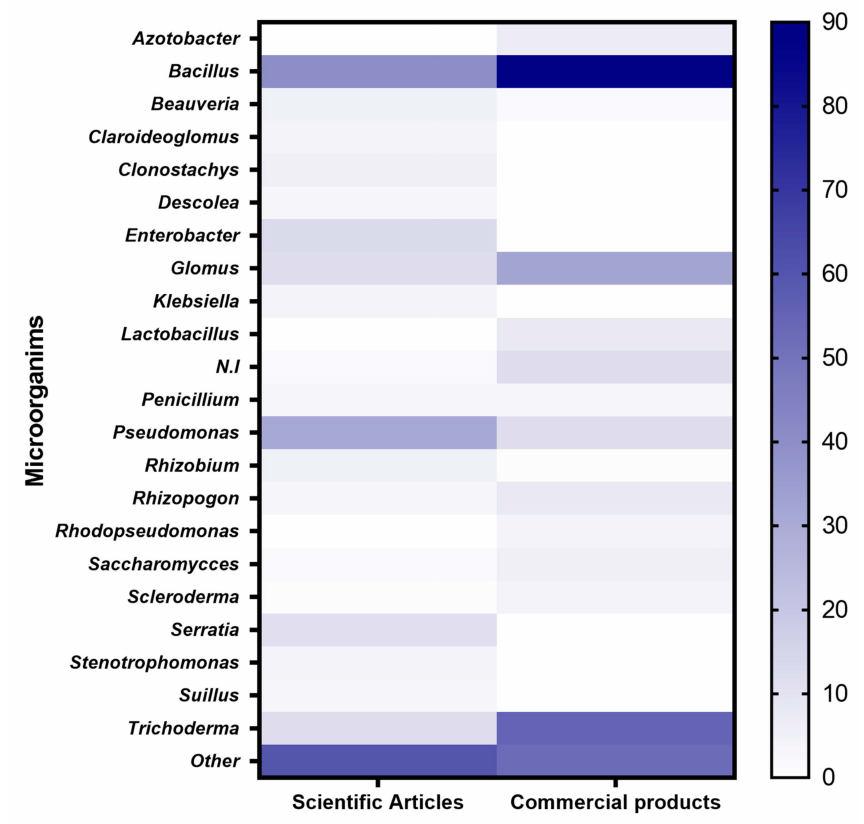
Figure 5. Microorganisms described in scientific publications and used in commercial products in Chile (Data Source: SAG, Chile; Table